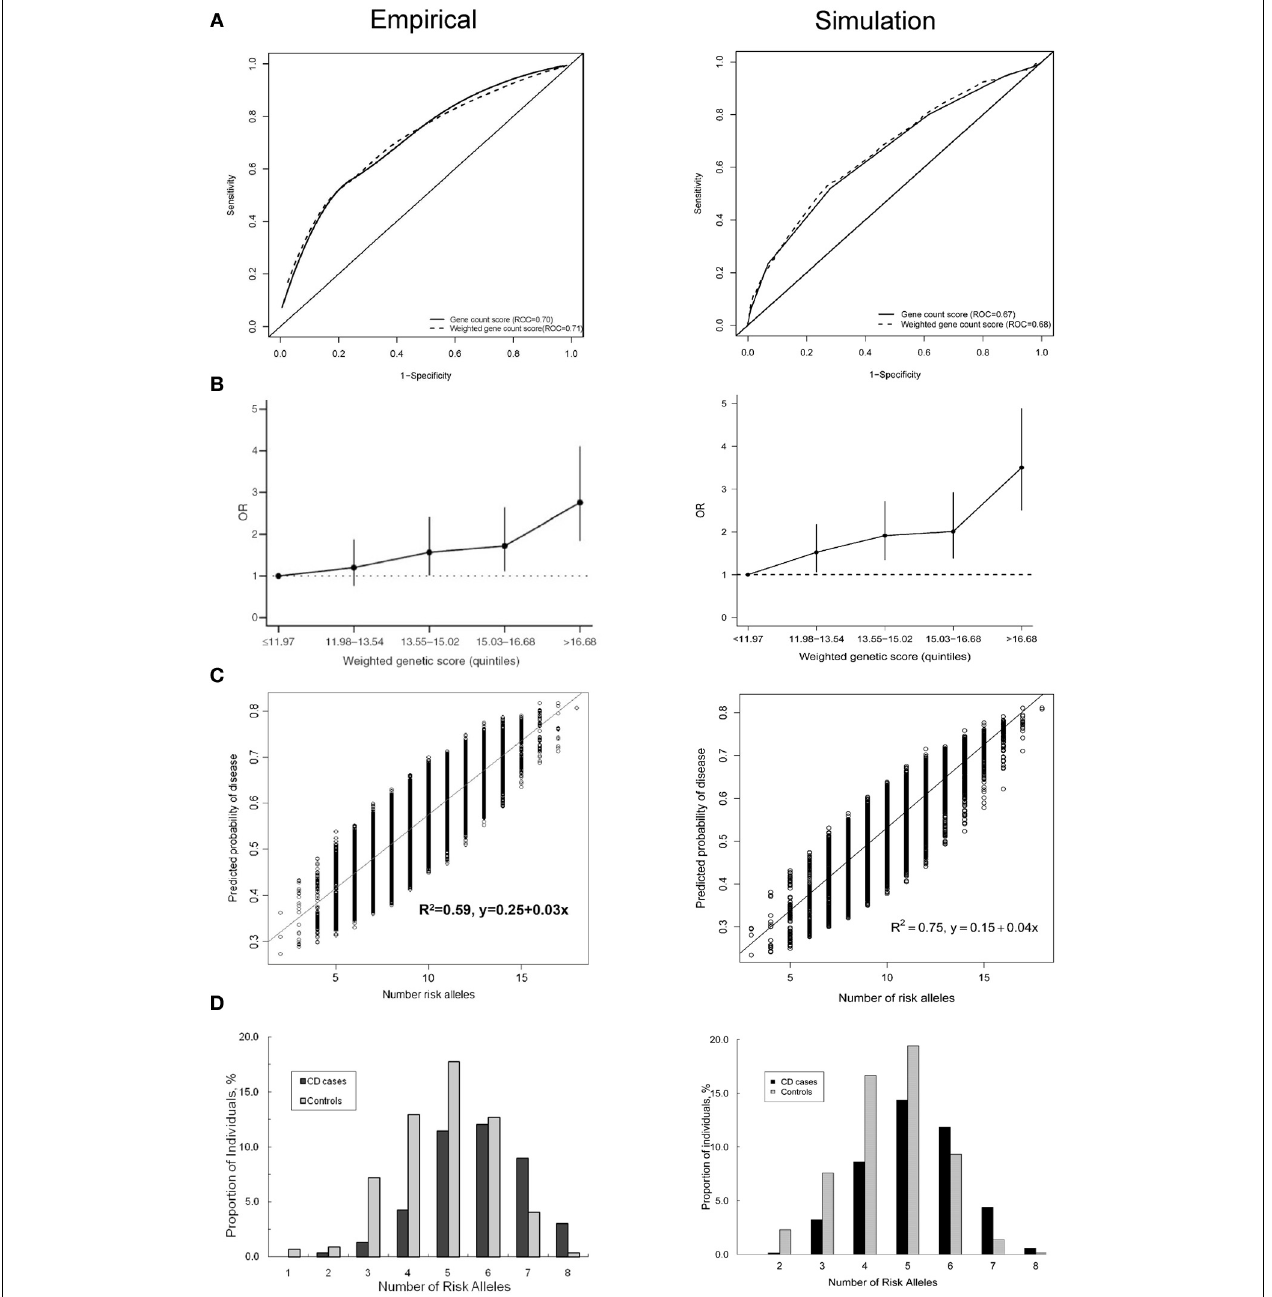
FIGURE 1 | Plots published in empirical prediction studies and their reproductions in simulated data. (A) Receiver operating characteristic (ROC) curves for unweighted and weighted gene count scores (Peter et al., 2011). (B) Quintiles plot presenting the odds ratios with 95% confidence intervals by